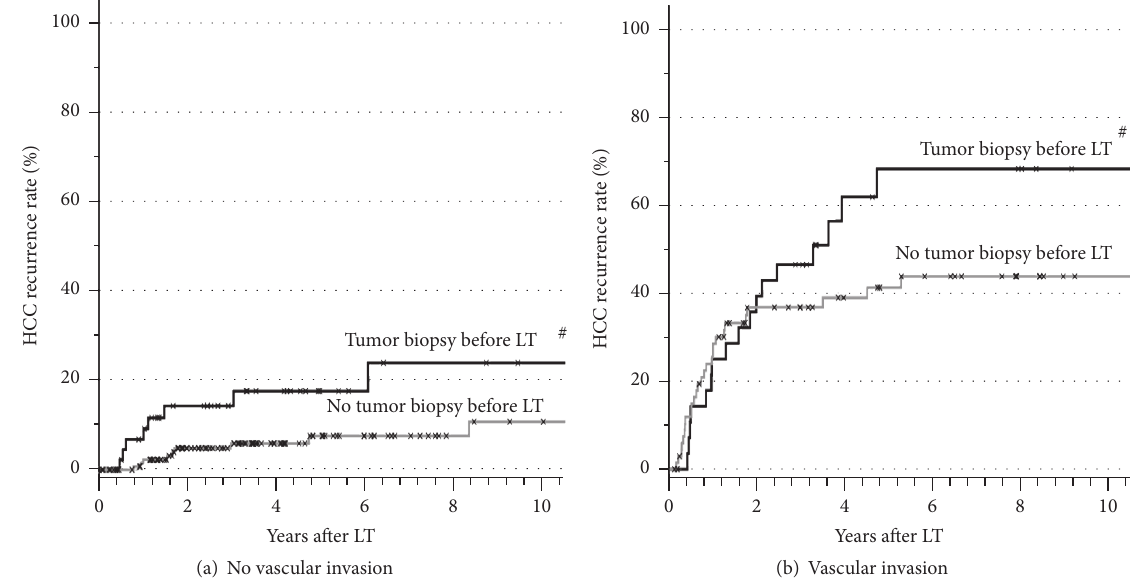
Figure 2: HCC recurrence rates in patients without (a) and with (b) microvascular invasion in correlation with pretransplant tumor biopsy ( # 𝑝 = 0.015 for tumor biopsy versus no tumor biopsy tested by stratified log rank test).